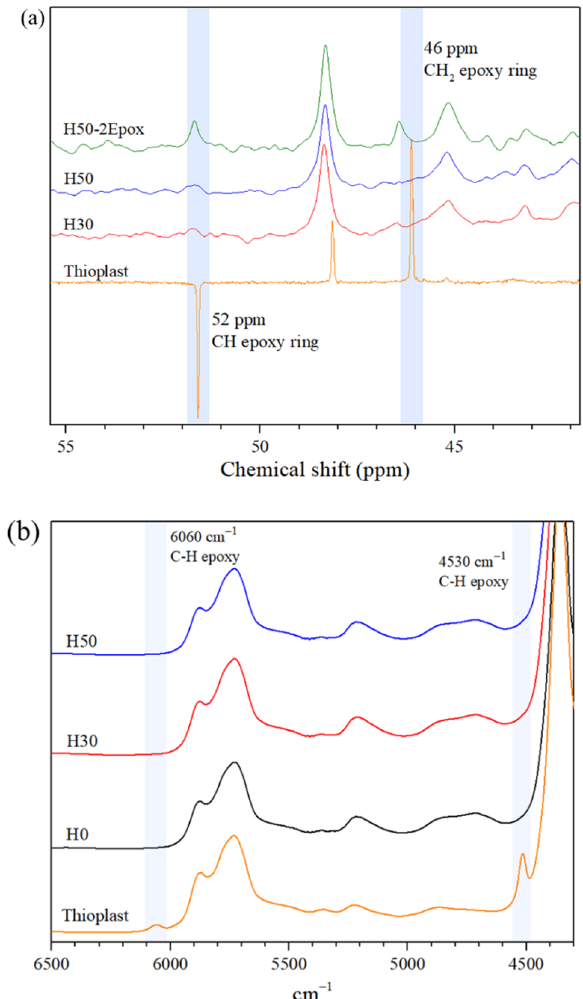
Figure 4. ( a ) 13 C{ 1 H} nuclear magnetic resonance (NMR) in acetone-D6, 13 C CPMAS and ( b ) nIR spectrum of pure Thioplast, H0, H30 and H50 films.